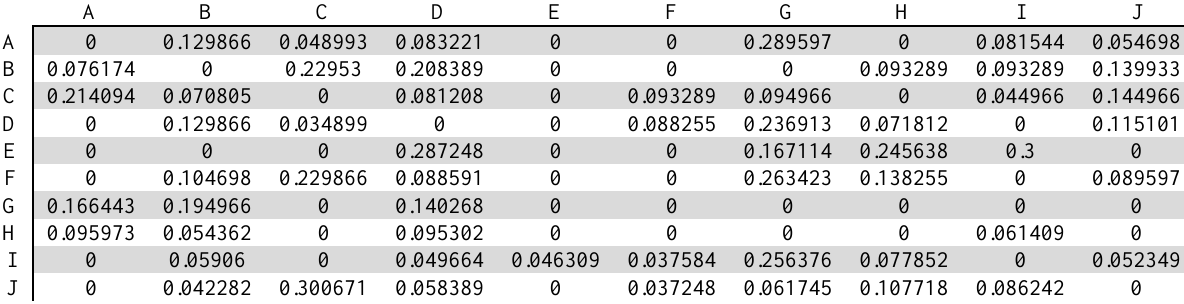
The normalized matrix of direct